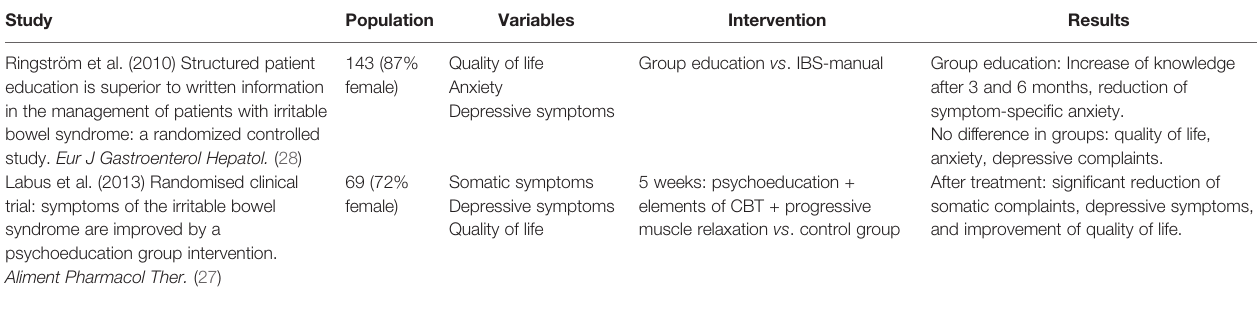
Study Population Variables Intervention